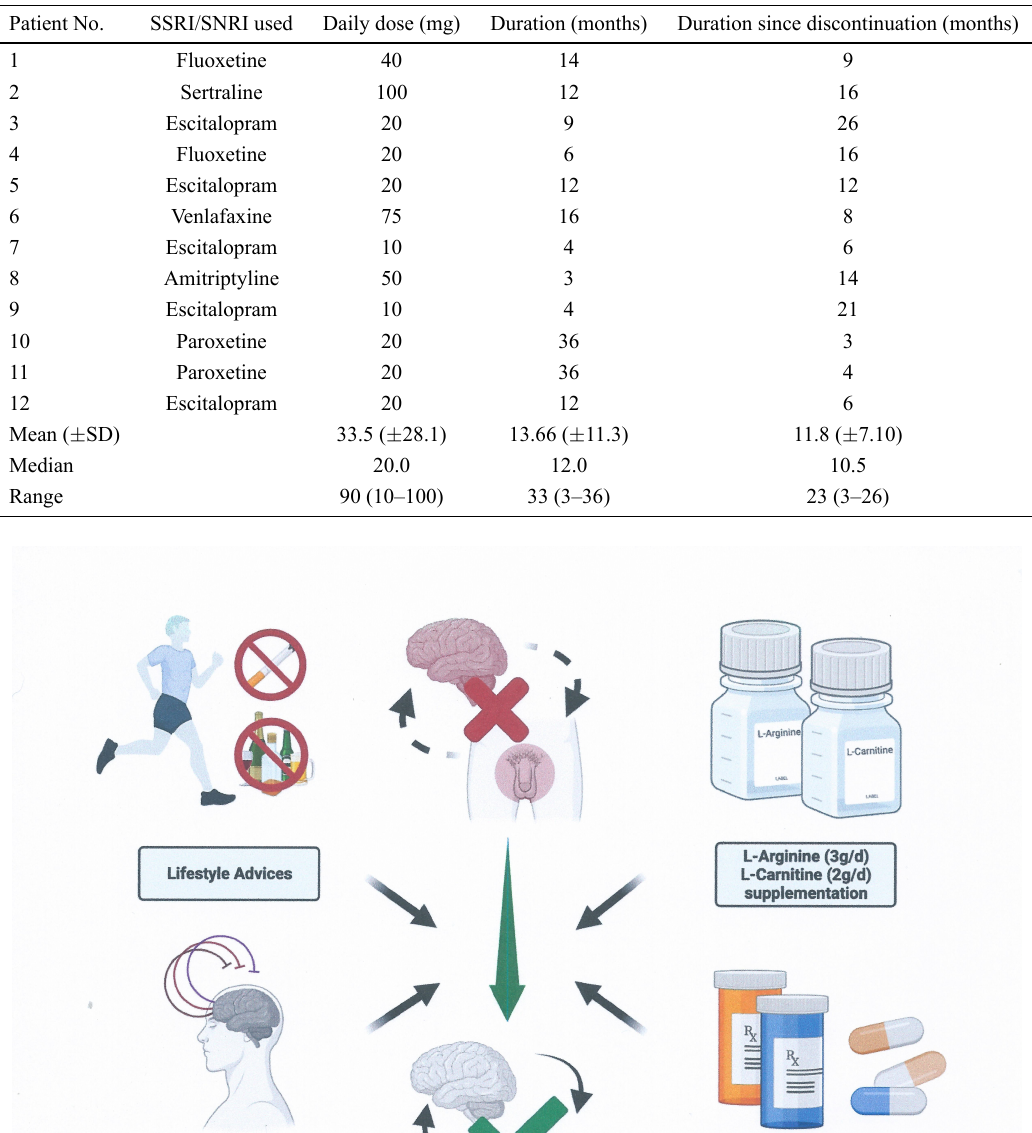
Table 2. SSRI/SNRI use and ceasing period of the patients. Patient No.